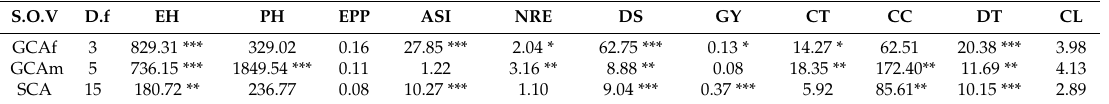
Table 3. Mean sum of square e ff ects of general combining ability of males (GCAm), general combining ability of females (GCAf) and specific combining ability (SCA) for yield, yield components and other morpho-agronomic traits under drought and heat-stressed conditions.